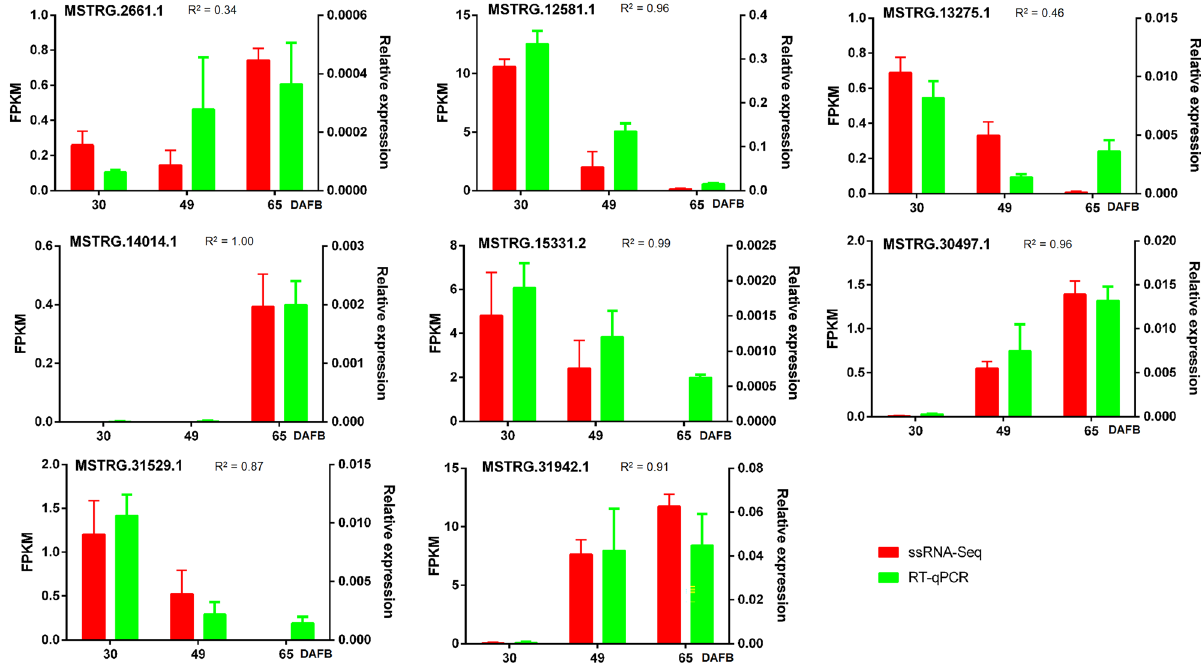
Figure 5. Expression profiles of randomly selected DELs by qRT–PCR and ssRNA-Seq. Error bars represent the SE of three biological replicates. R 2 , the correlation coefficients of Pearson correlation analyse.